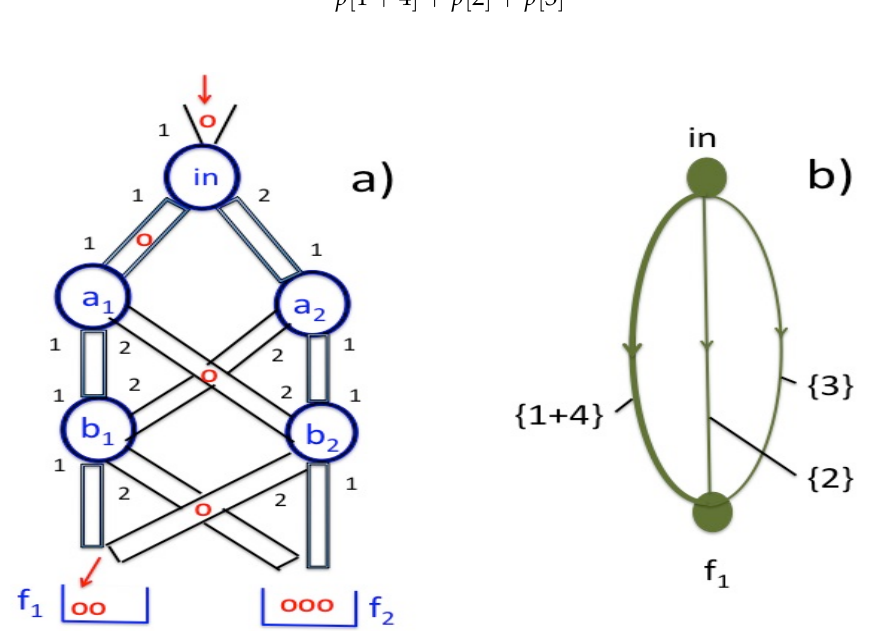
Figure 1. ( a ) Schematic diagram of the toy model of Section 4. A ball is introduced at the top and follows the path { 3 } before ending up in the receptacle f 1 . The numbers mark the inlets and outlets of a connector, with the closed ones not shown; ( b ) A reduced model for the system post-selected in f 2 , with only F 2